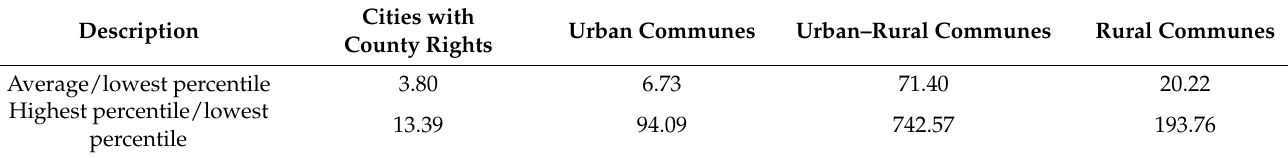
Table 10. Differentiation of the surface of the revitalisation area in the respective types of the communes.